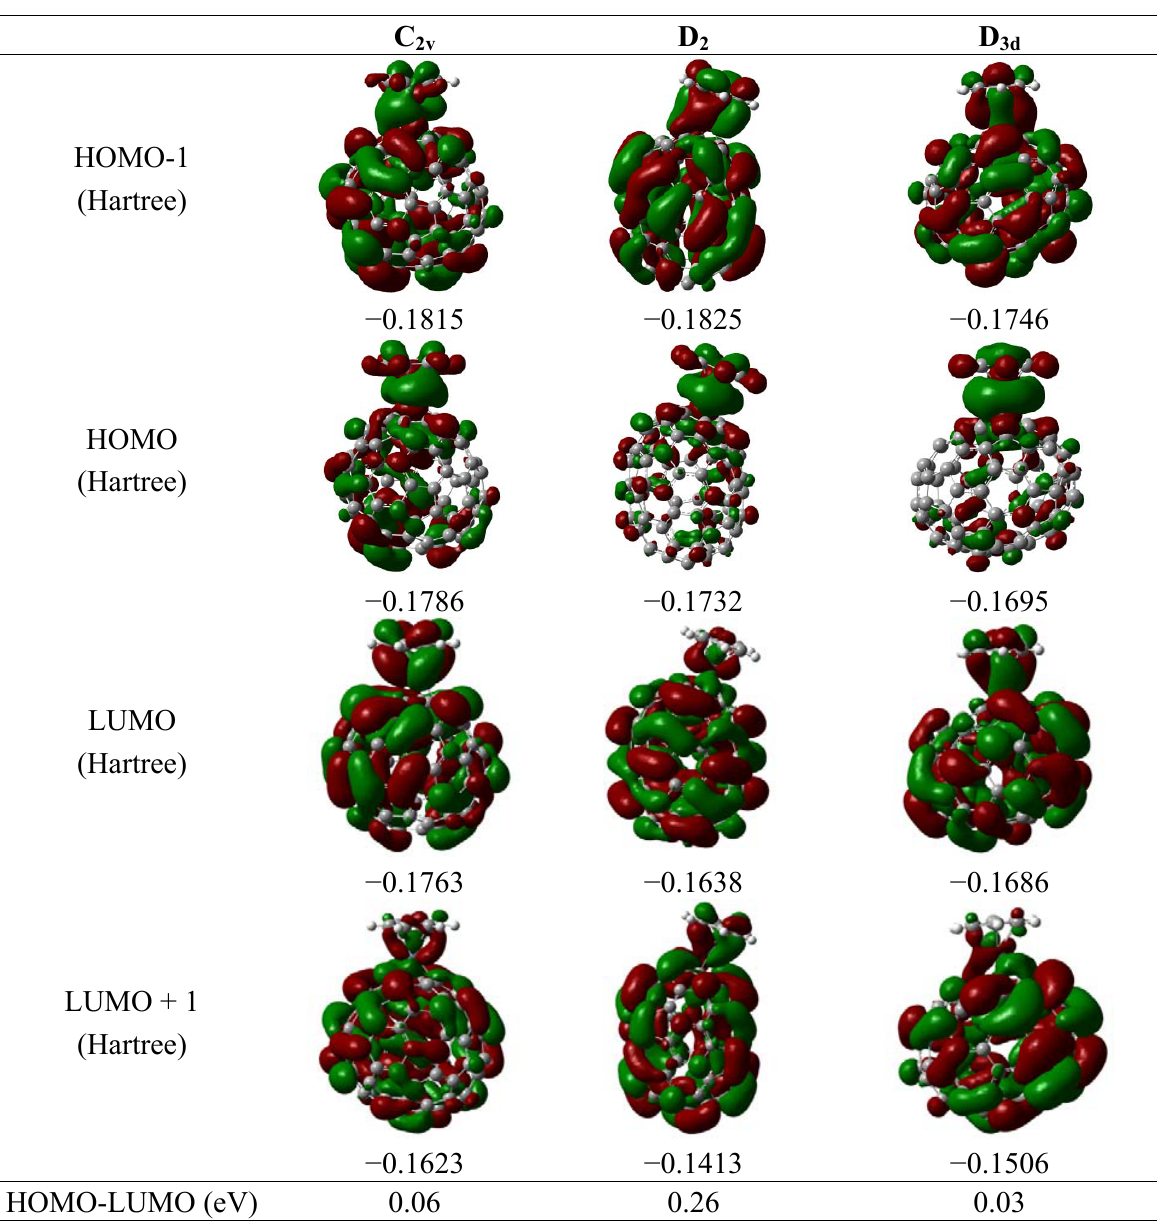
Figure 2. Frontier molecular orbital of the isomers C